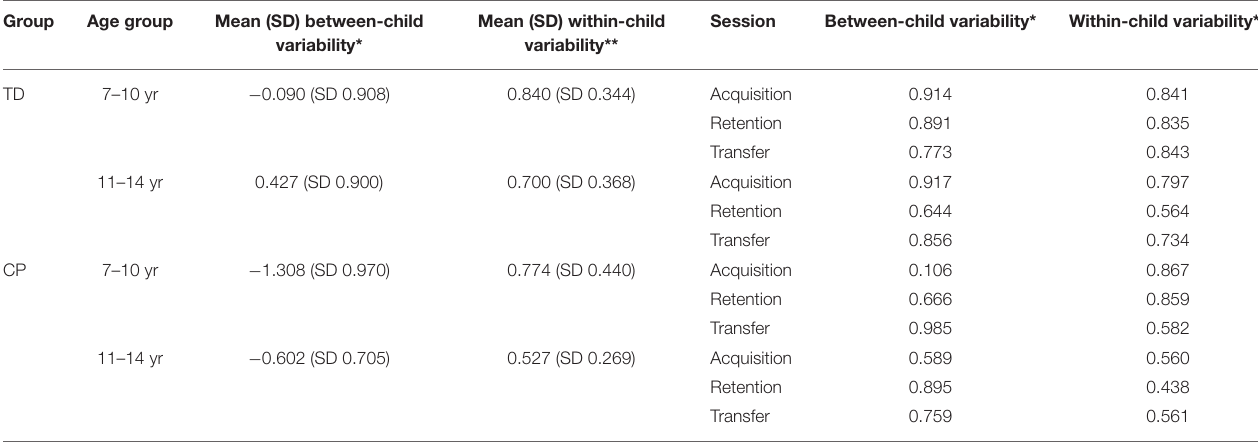
TABLE 4 | Within- and between-child variability for each age group and for each age group at each session. Group Age group Mean (SD) between-child Mean (SD) within-child Session Between-child variability* Within-child variability** variability* variability** TD 7–10 yr − 0.090 (SD 0.908) 0.840 (SD